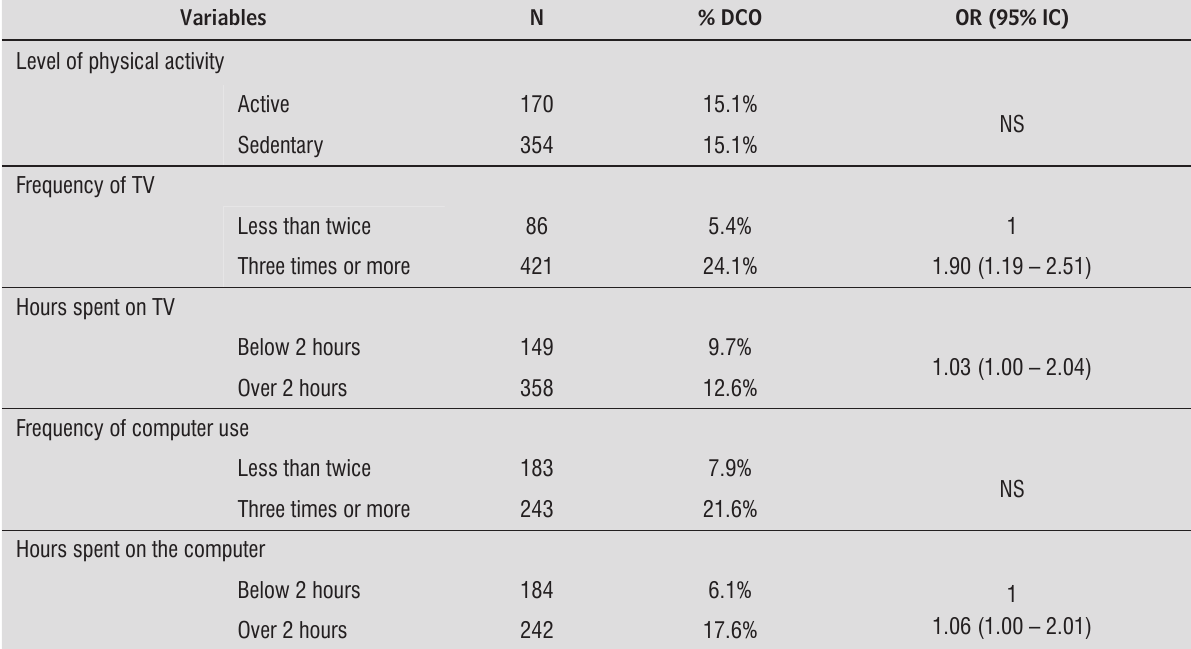
Table 2 - Result of the multivariate binary logistic regression, final model for independent associations with pain in the neck/shoulders among male school students, Bauru - 2009